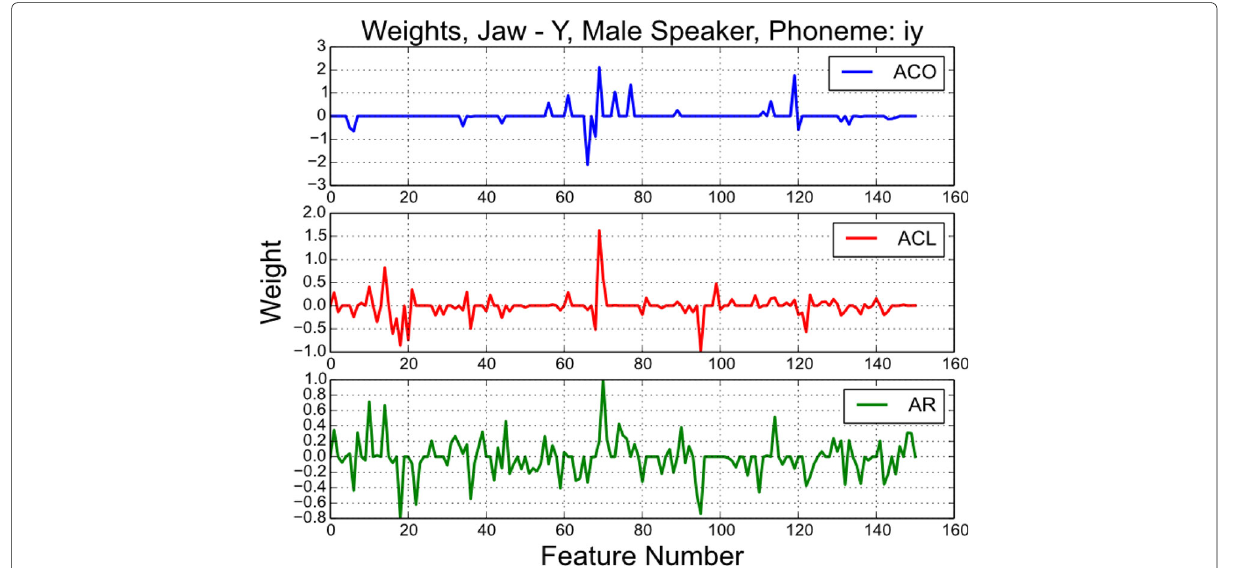
Fig. 5 A comparison of weight vectors learnt from different training criteria. (Top row) ACO: emotion recognition using only logistic regression, (middle row) proposed ACL method, and (bottom row) AR: least squares regression over the articulatory target